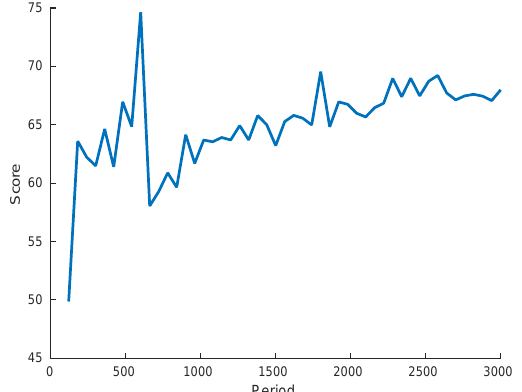
Figure 9: Score of MPE-SAC over first periods of best (periods, starting points)